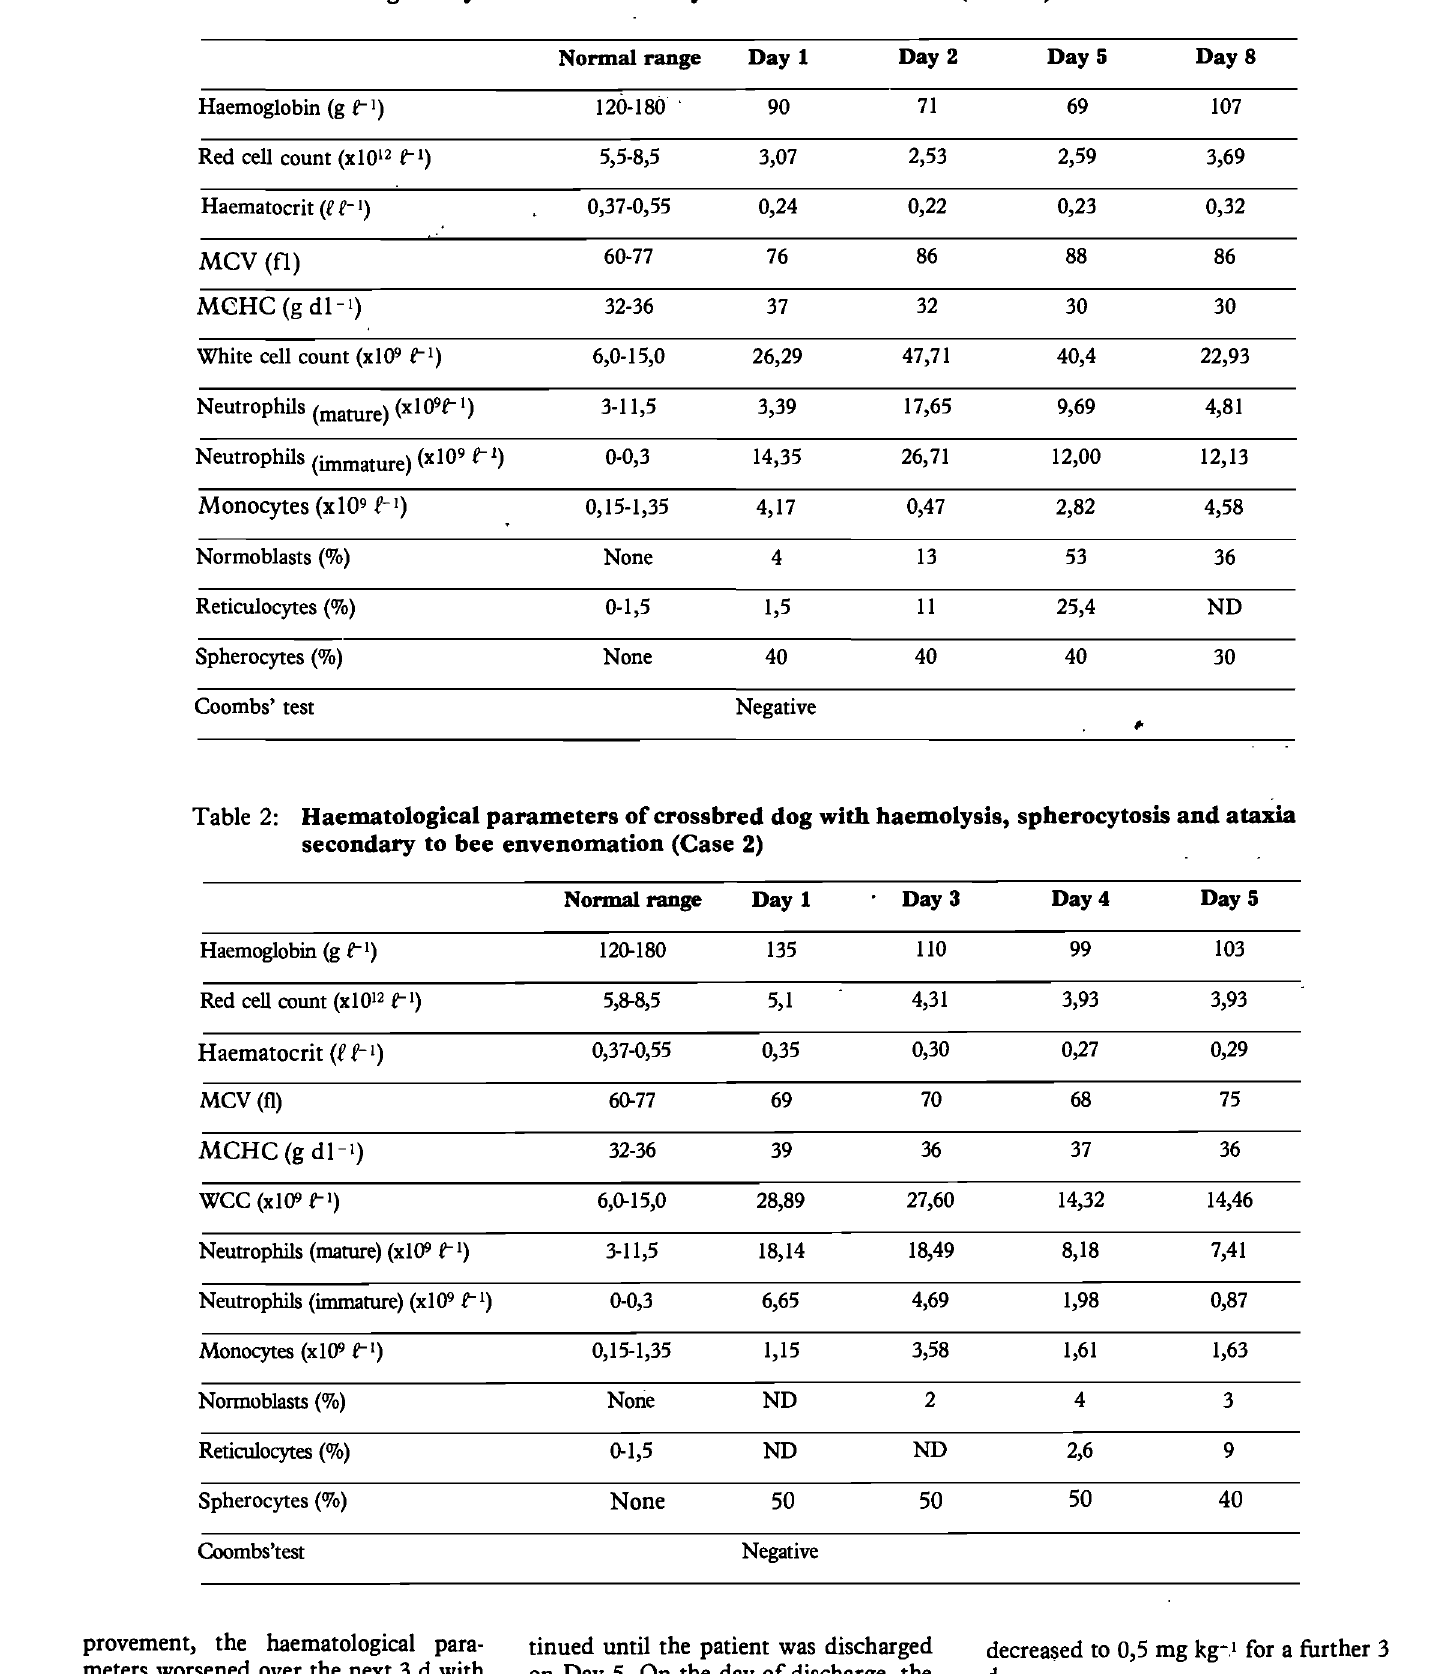
:rahle 1: Haematological parameters of Cocker Spaniel with anaemia, spherocytosis and neurological dysfunction secondary to bee envenomation (Case 1)